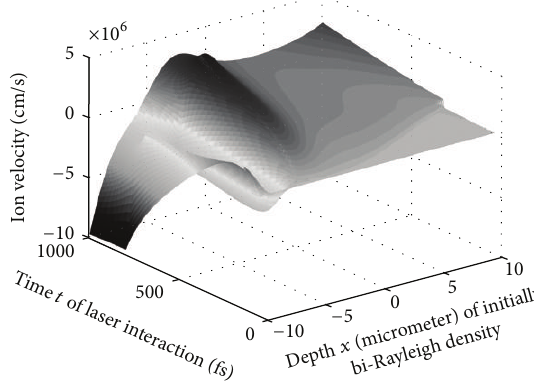
Figure 11: Ion velocity within an initially bi-Rayleigh 𝛼 = 9.59 × 10 3 cm −1 deuterium plasma with initially zero velocity and with 100 eV initial temperature located between 𝑥 = 10 and +10𝜇 m at neodymium glass laser irradiation from the left hand side of 2 × 10 16 W/cm 2 intensity during the time between 0 and 750 fs